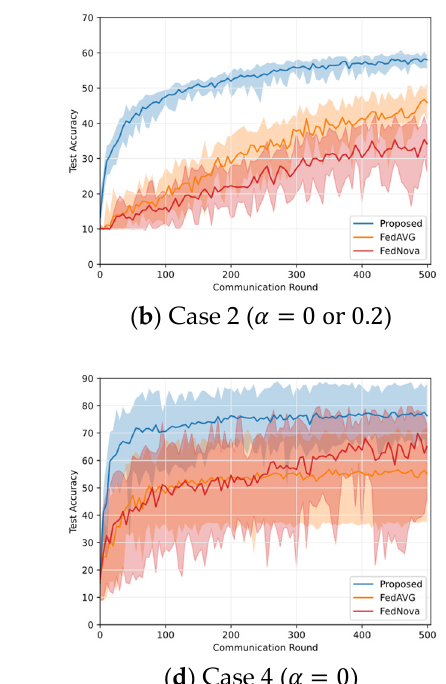
the results of the CIFAR-10 dataset, and Case 4 is the result of the MNIST